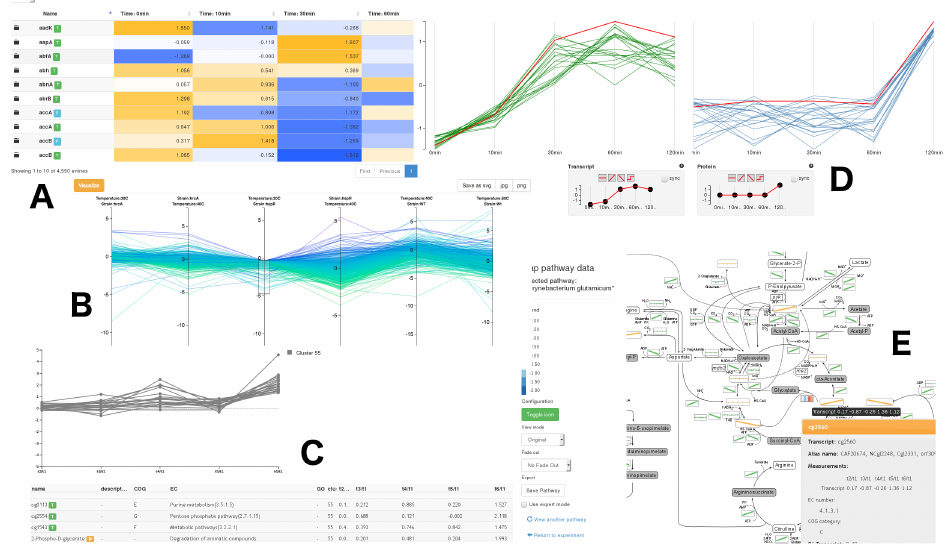
Figure 1: Omics Fusion offers various visualization approaches for single- and polyomics data. This figure shows examples for: (A) Data management screen, (B) Parallel Coordinates, (C) Clus- ter Profiles, (D) Visual Profiling, (E) Pathway